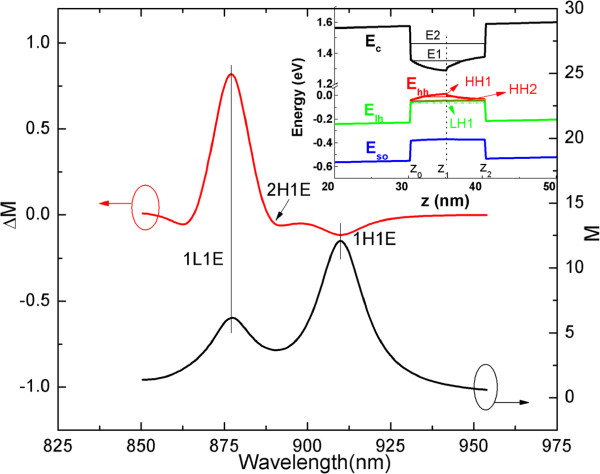
The calculated anisotropic transition probabilityΔM and the average transition probabilityM. The vertical lines and arrows indicate the transition positions of 1H1E, 2H1E, and 1L1E. The inset shows the calculated energy band alignment of In0.15Ga0.85As/GaAs/Al0.3Ga0.7As step QWs with segregation length of indium atoms l = 2.8 nm and internal field F = 12.3 kV/cm. Ec, Elh, Ehh, and Eso represent the energy band alignment of the electron band, light-hole band, heavy-hole band, and the spin-orbit split-off band, respectively.